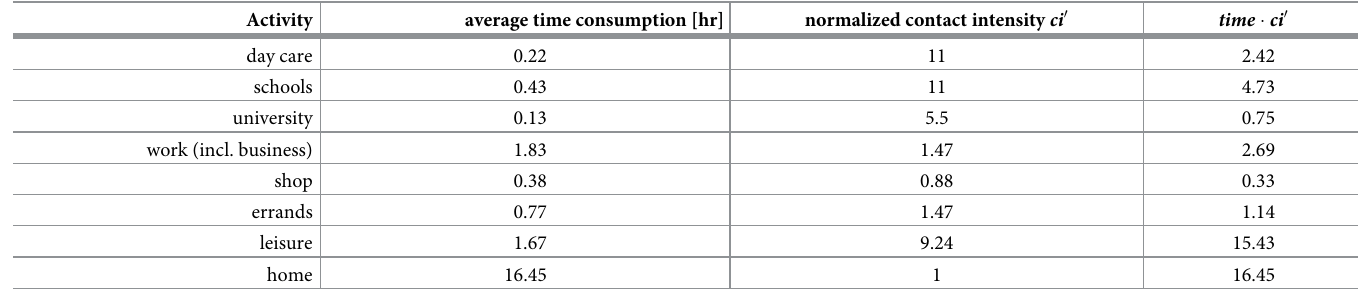
Table 4. Average time consumption of out-of-home